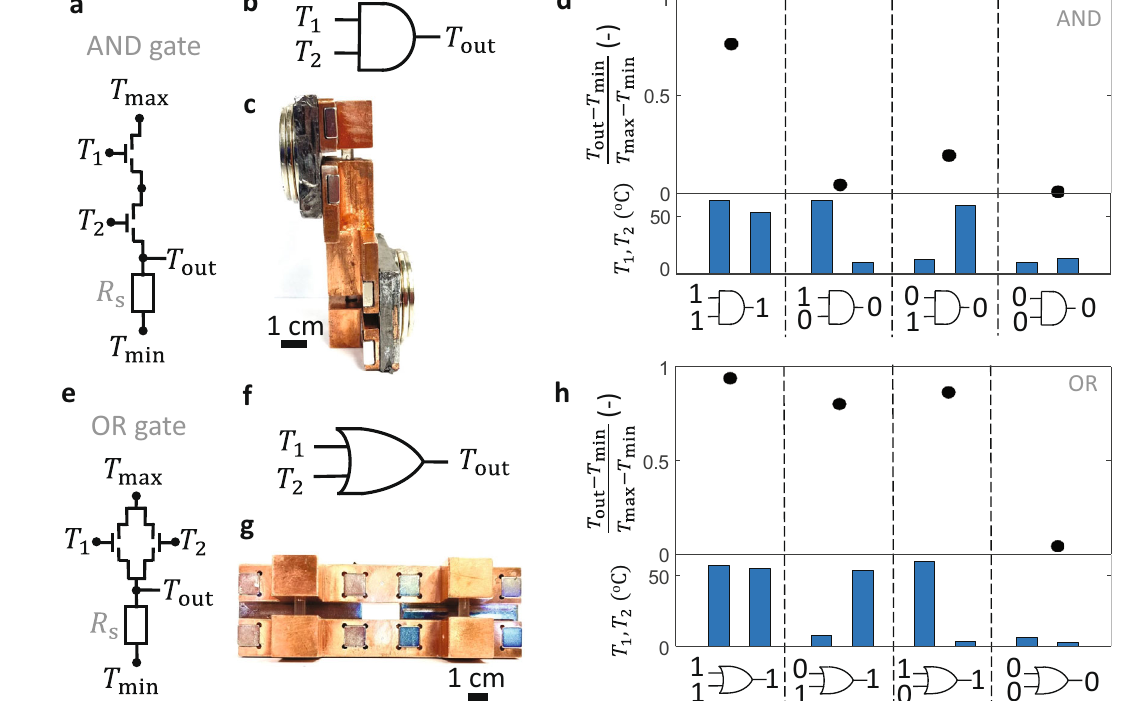
Fig. 6 | Thermal logic gate demonstration. a Thermal circuit schematic, b logic gate representation, and c image of thermal AND gate using two transistors ther- mallyinseriesbetweenamaximumsupplytemperature T max andminimumsupply temperature T min . The input temperatures T 1 and T 2 are connected to the gate terminals, and the output temperature T out is separated from T min by a series thermal resistor R s . d Measured AND gate truth table. The output normalized